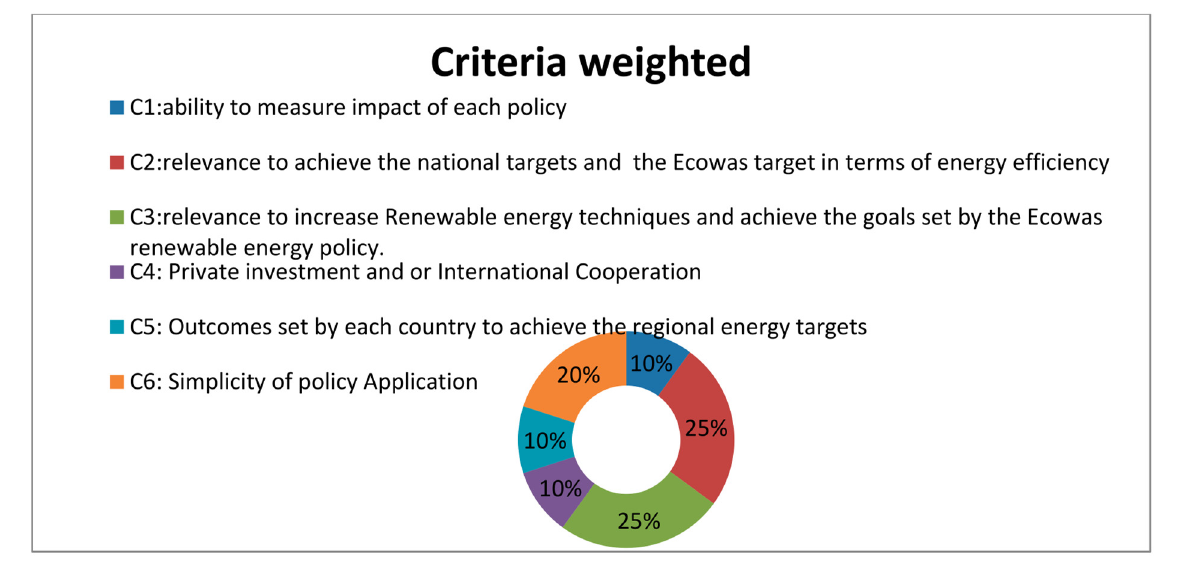
Figure 4. Criteria weighting .